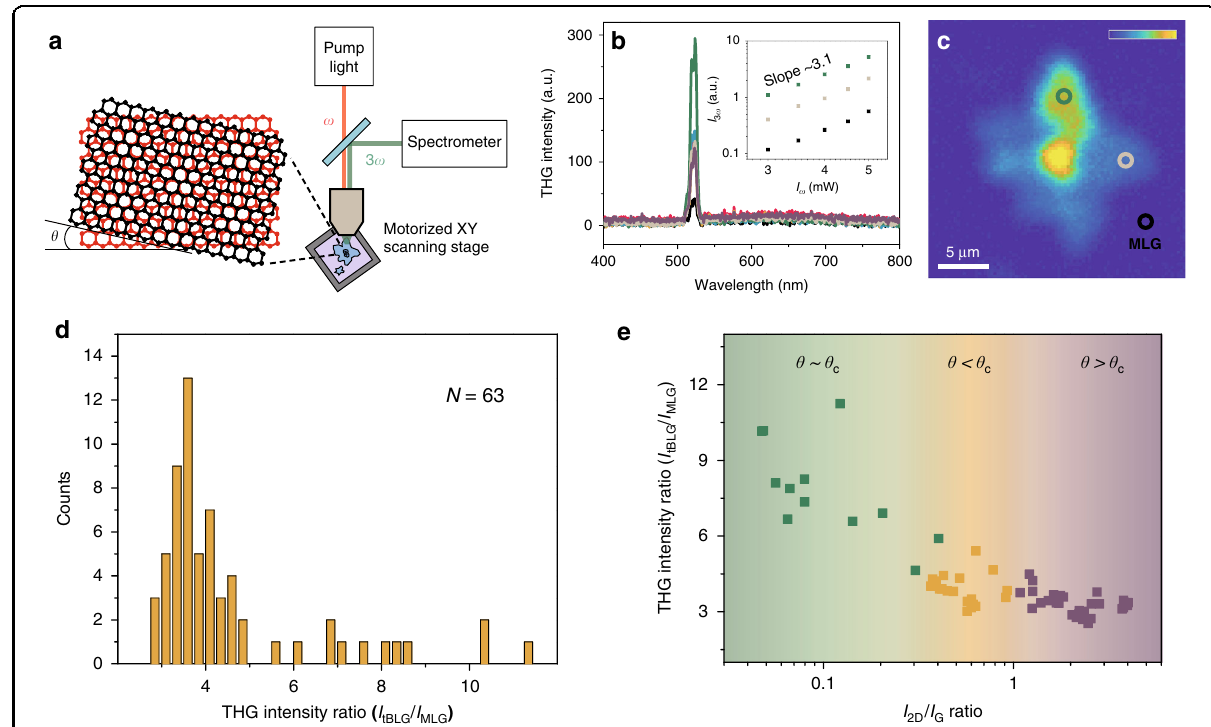
Fig. 2 θ -dependent THG responses in tBLG. a Schematic of our lab-made re fl ection-type measurement system for nonlinear optical responses in tBLG. b Spectra of nonlinear optical signals from MLG and tBLG over visible wavelengths. The dominant spectra show the typical THG signals centred at 520 nm. Inset: output power dependence of THG signals on pump power. The slopes are near 3, indicating intrinsic THG characteristics. These data were measured at the MLG (black circle) and tBLG (grey and green circle) positions in ( c ). c THG image of the graphene region in Fig. 1b, scanned by motorized XY stages with a 0.3 μ m step resolution over 30 μ m × 30 μ m. d Histogram of the THG intensity ratio for 63 tBLG regions and MLG. e Tendency of the THG intensity arranged with respect to the 2D/G peak